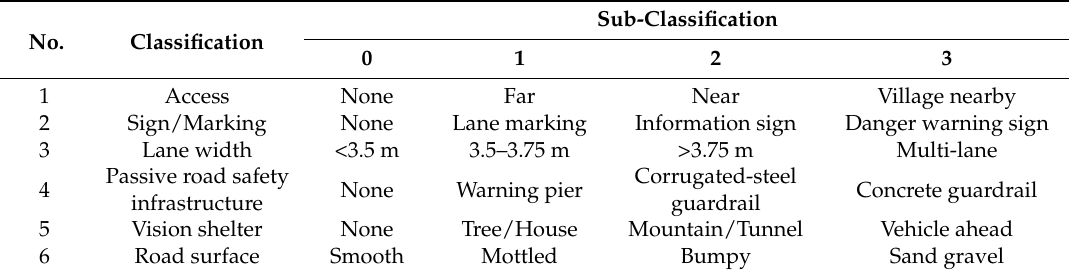
Table 4. Visual Information Classification of Traffic/Road Environment.